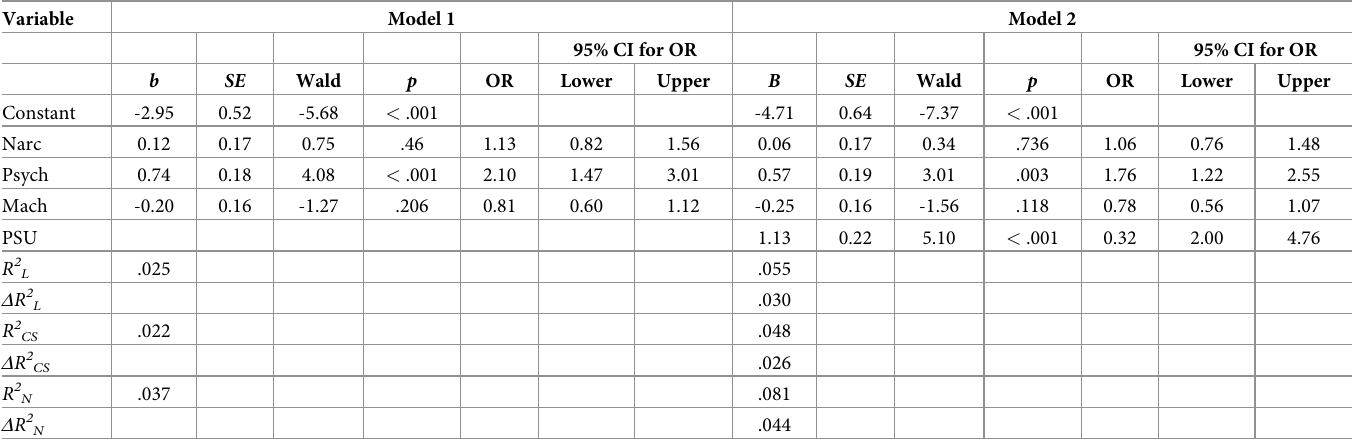
Table 6. Logistic regressions for Dark Triad and problematic smartphone use predicting the odds of a penalized traffic offense in the last 12 months. Variable Model 1 Model 2 95% CI for OR 95% CI for OR OR Lower Upper Constant